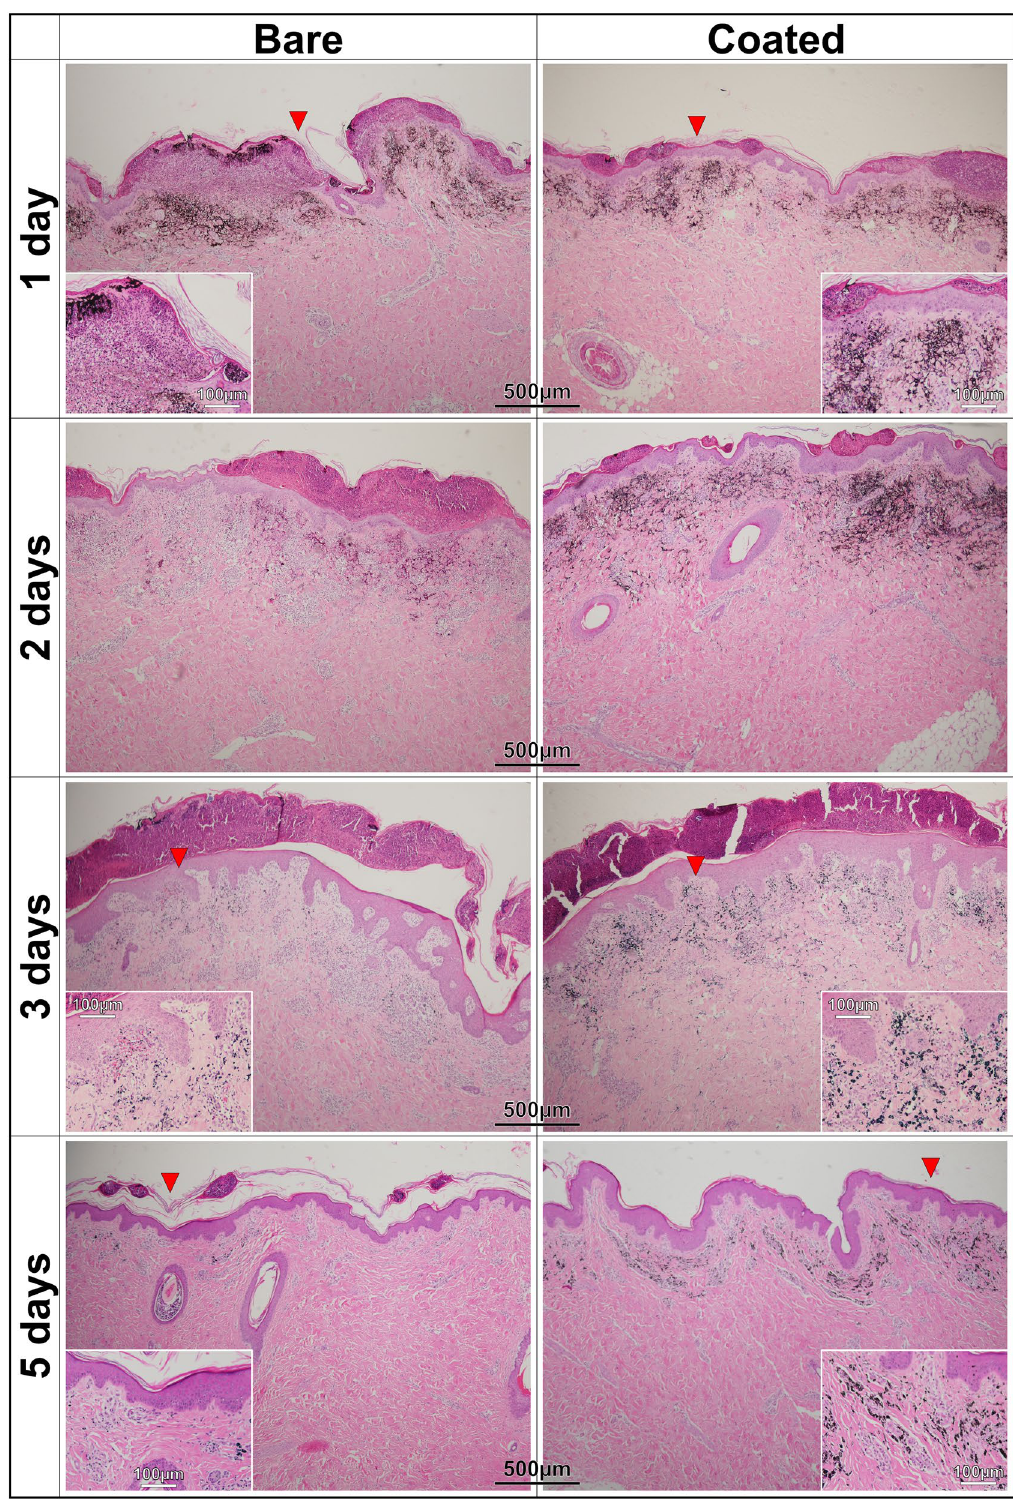
Figure 9. Histopathological images of pig skins taken after 1, 2, 3 and 5 days following tattooed in black pigment by bare and coated 5-needle sets. Red arrows designate the areas for magnified views in their respective